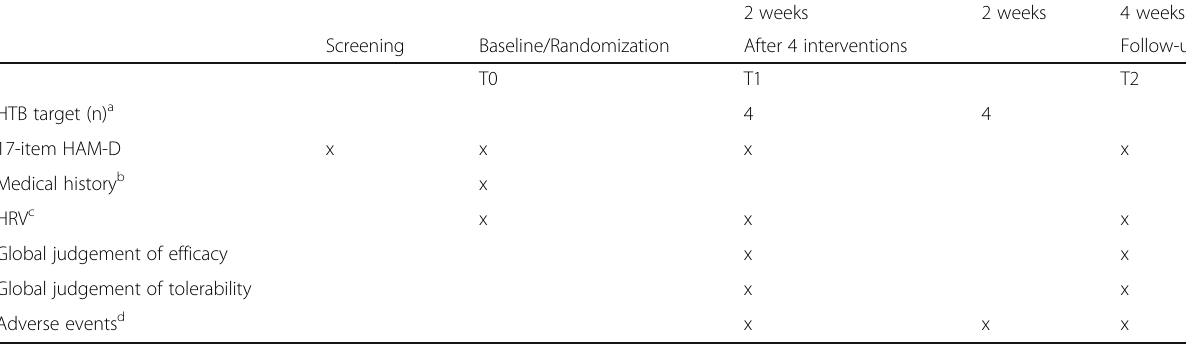
Table 1 Diagram of the study protocol